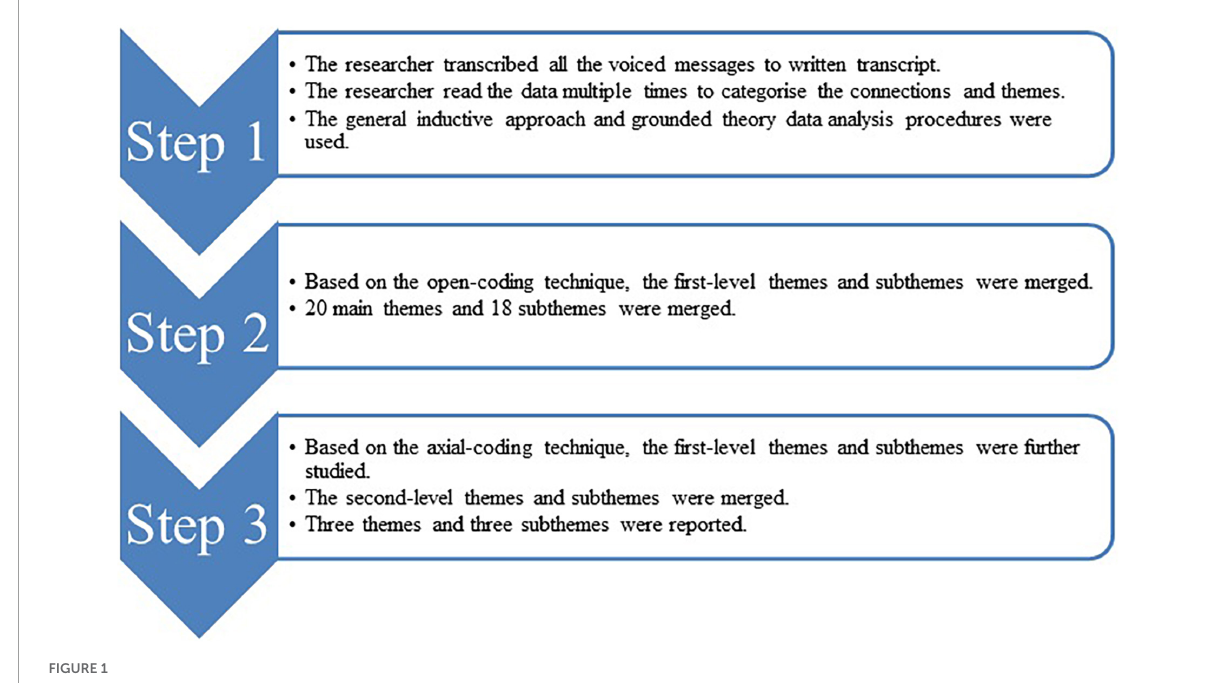
FIGURE1 Data analysis